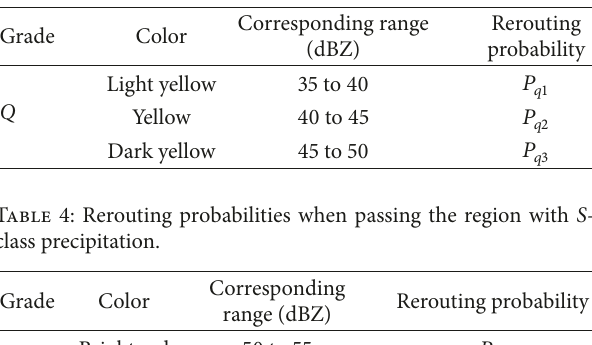
Table 3: Rerouting probabilities when passing the region with Q - level precipitation.